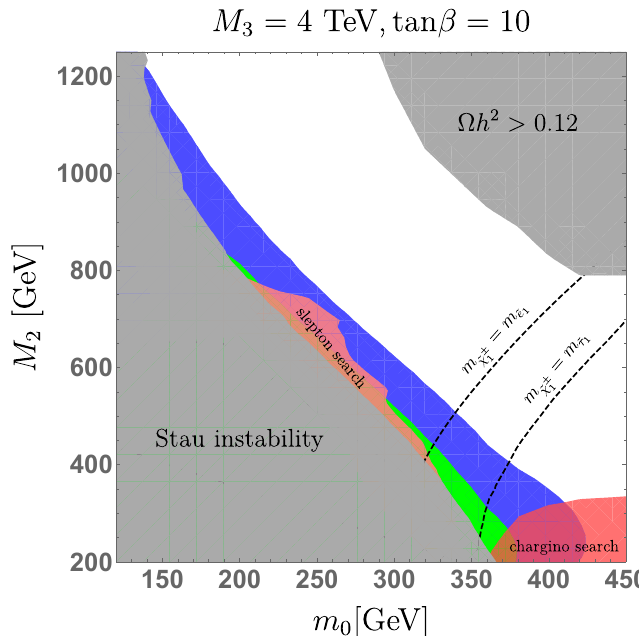
Figure 2 . Results with universal soft scalar masses. The dark matter relic density is satisfied everywhere except the grey regions (see text for details). The green (blue) regions are consistent with the muon g 2 at 1(2) σ . The pink and red regions are excluded by ATLAS slepton [53] and − chargino [55] searches